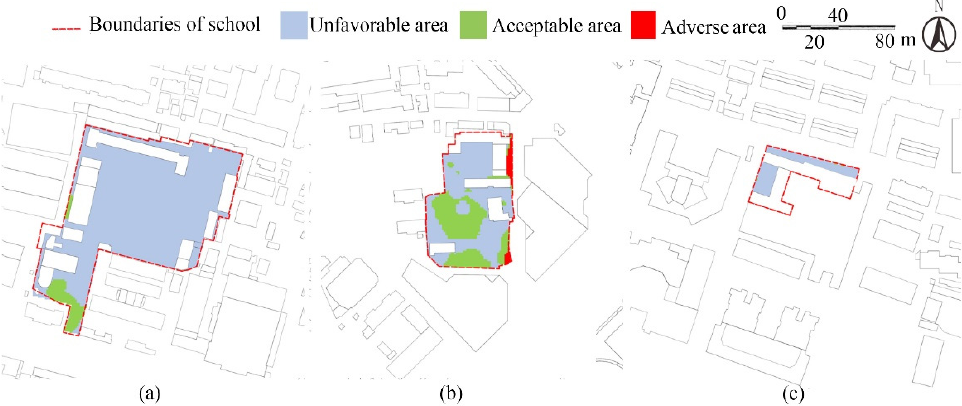
Figure 11. Distribution of wind comfort zones at the pedestrian level in three primary schools in winter in the 1990s: ( a ) Changjiang Road Primary School; ( b ) Chibi Road Primary School (Shanxi Road Campus); ( c ) Jianye Road Primary School.